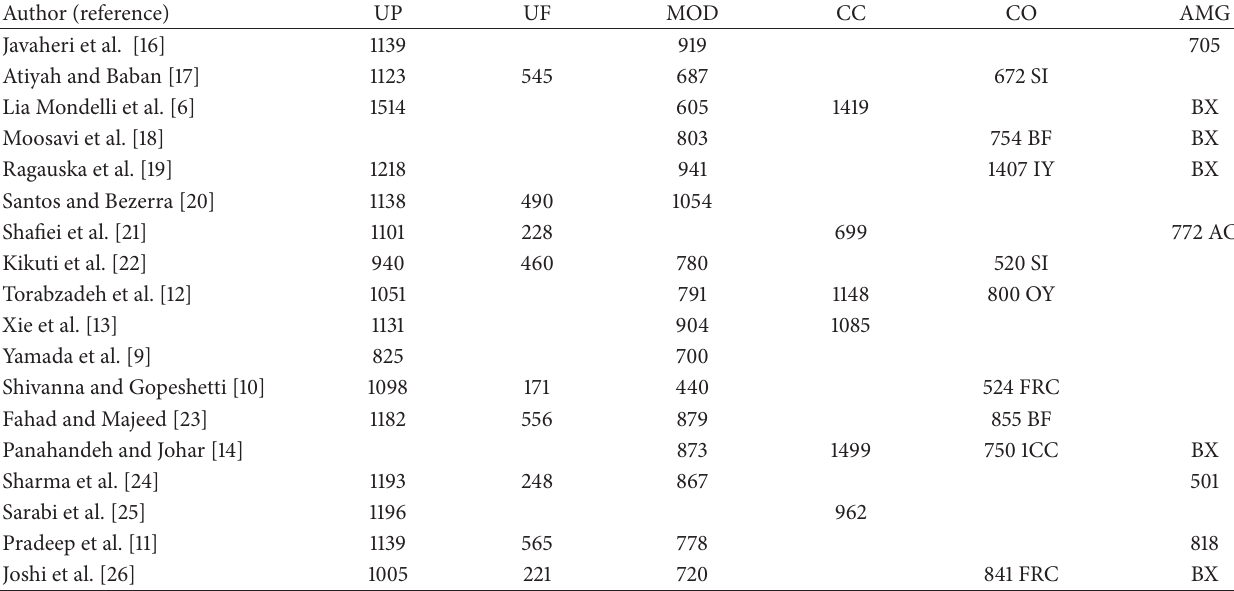
Table 4: Summary of other studies testing the mechanical resistance on